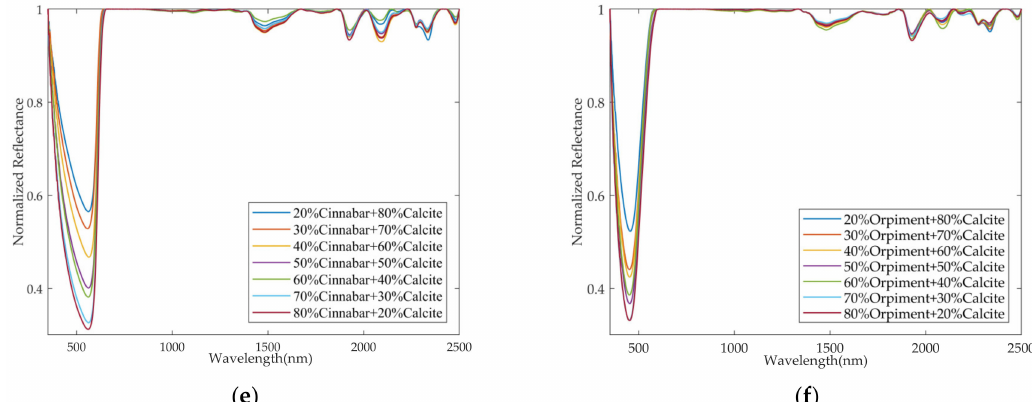
Figure 10. Normalized reflectance spectra of pure pigments and mixed pigments with different mass ratios after continuum removal: ( a ) pure pigment normalized reflectance spectra; ( b ) the mixture of azurite and malachite normalized reflectance spectra; ( c ) the mixture of azurite and orpiment normalized reflectance spectra; ( d ) the mixture of cinnabar and orpiment normalized reflectance spectra; ( e ) the mixture of cinnabar and calcite normalized reflectance spectra; ( f ) the mixture of orpiment and calcite normalized reflectance spectra.